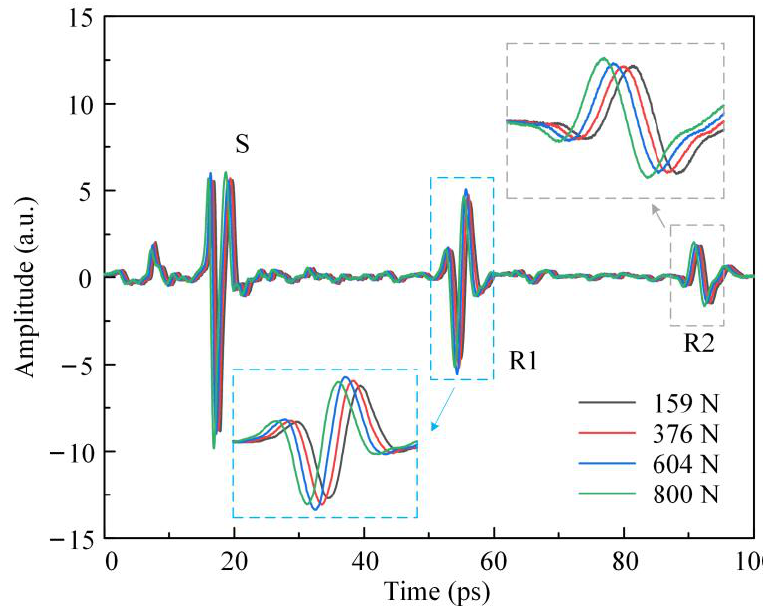
Figure 2. Diagram of the reflective terahertz time-domain spectroscopy.